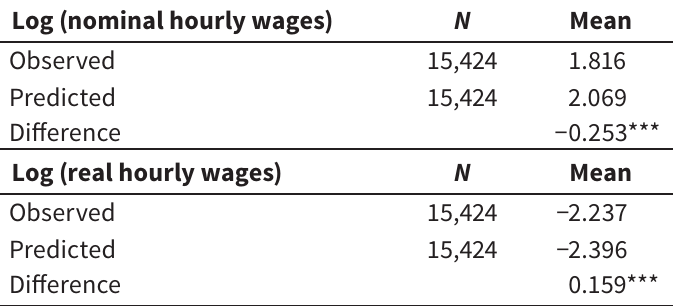
Differences in actual and predicted wages for metropolitan out-migrants, after matching Log (nominal hourly